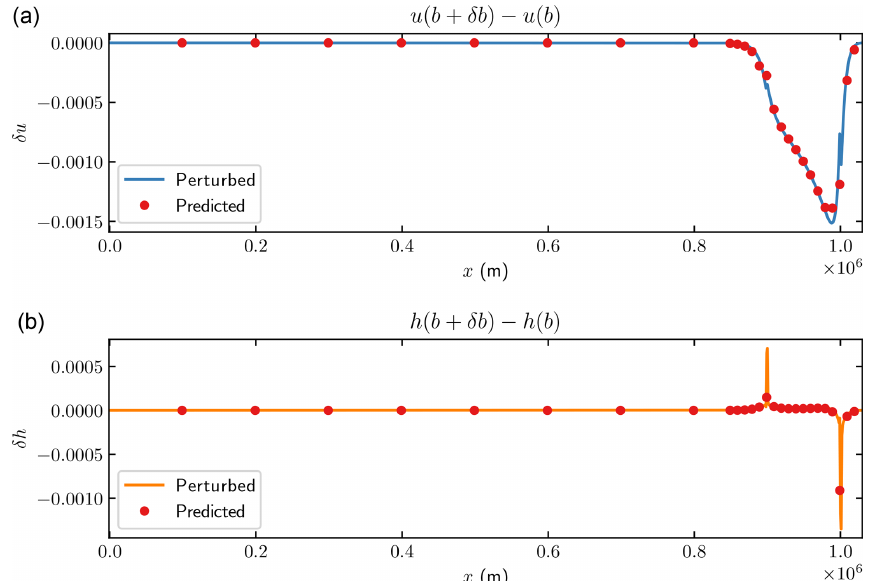
Figure 11. The changes in the horizontal velocity u (a) and surface elevation h (b) for SSA after 1 year with 0 . 01m perturbation of b(x) in x ∈ [ 0 . 9 , 1 . 0 ]× 10 6 m. Solid lines are the differences between the steady-state and the perturbed solutions in Eq. (13). Red dots represent the estimated perturbation using Eq.